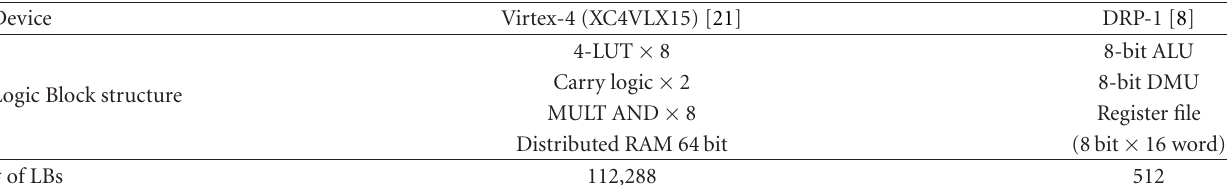
Table 1: Structures of typical RLDs.